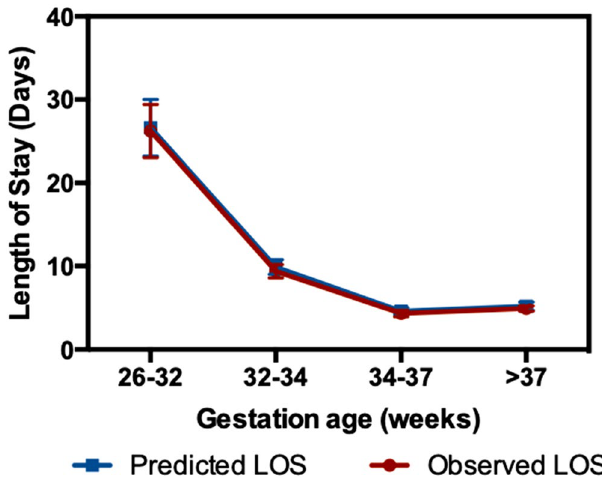
Figure 6. Model performance over 4 months validation data. R 2 for < 32 gestation week is 0.95, for 32 to 34 is 0.74, for 34–37 is 0.62, for ≥ 37 is 0.64.